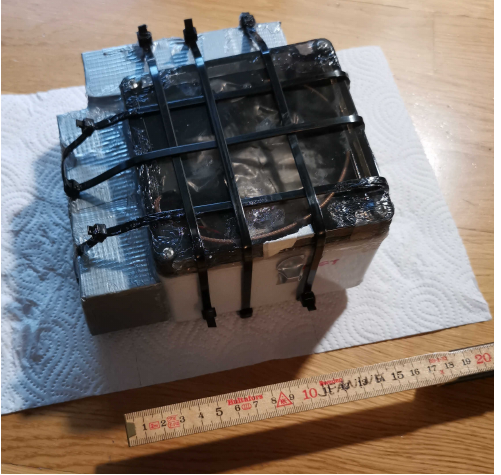
Figure 8. The “Floatenstein” drifting buoy. The main body of the buoy is a rectangular plastic box of dimensions 12 cm × 12 cm × 9 cm. Due to the use of alkaline batteries instead of lithium batteries, additional flotation elements were needed. These are the two rectangular elements on the side of the main body of the buoy, which are built from styrofoam chunks, wrapped in duct tape, and held in place by cable ties. The full box is sealed with epoxy to be perfectly watertight. To avoid the need for making holes in the box, the Iridium antenna is also taped in place inside the box, immediately under the lid, pointing 45 degrees upwards. The small cubic magnet (wrapped in duct tape to hold it in position under transport), which controls the magnetic switch glued on the inside of the box, is visible on the front panel of the main body of the